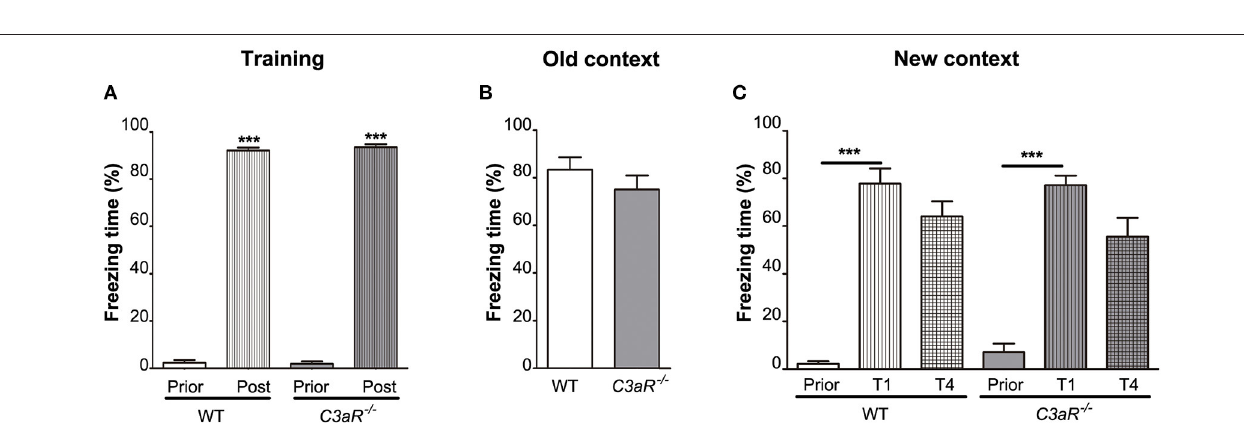
FIGURE 3 | C3aR − / − mice exhibit normal formation and extinction of fear memory. Assessment of learning and memory by contextual/cued fear conditioning test. Relative time spent in freezing behavior during (A) training, and testing in (B) the old context without auditory cue, (C) new context in response to auditory cue. Prior, post, before and after electric shock, respectively (A) ; Prior, T1, T4, before and after the first and fourth exposure to auditory cue, respectively (C) . n = 19 (WT) and 9 ( C3aR − / − ). Mean ± SEM. *** p < 0.001 for within group comparisons. Two-tailed unpaired Student’s t -test (B) and two-way ANOVA followed by a Tukey’s multiple comparisons post-hoc test (A,C)